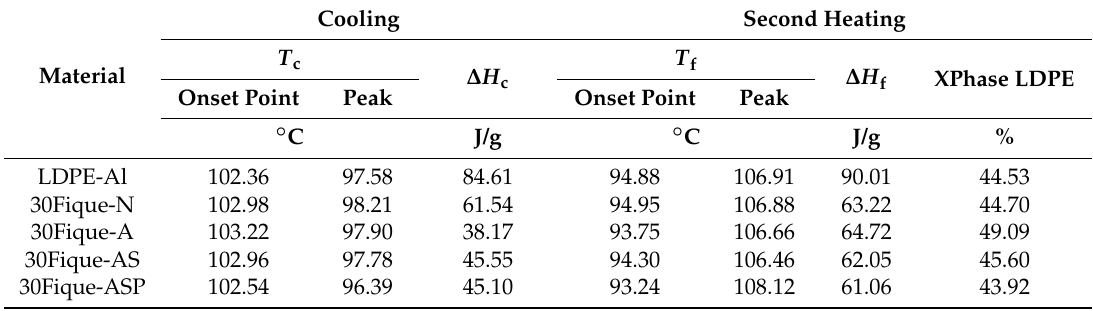
Table 2. Parameters obtained from the Differential Scanning Calorimetry (DSC) analysis of the LDPE-Al and composites with 30% fique fibers with different surface